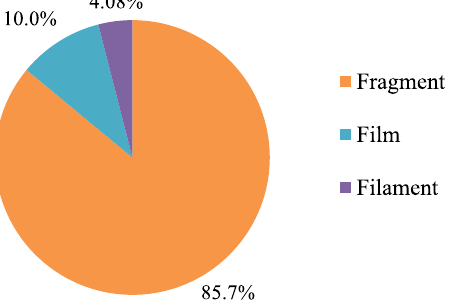
Figure 4. Pie chart of the morphology of isolated anthropogenic particles.